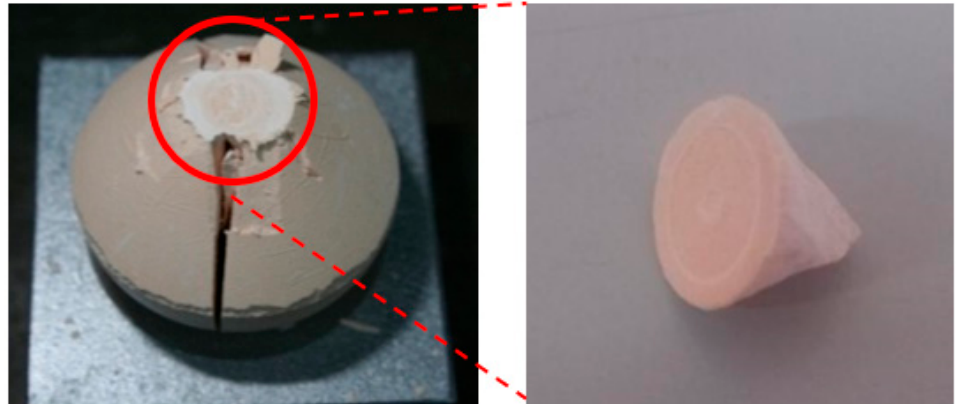
Figure 7. Conical core formed during the particle breakage. Table 3. Particle breakage modes. Table 3 listed the breakage modes for the cone–hemispherical gypsum particles.